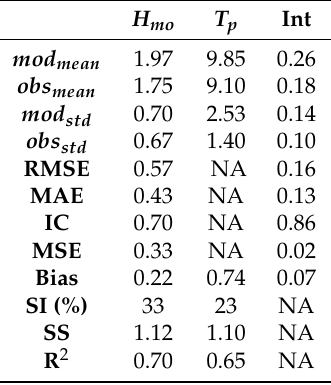
Table 2. Comparison between statistical metrics for wave and current data. Spectral significant wave height ( H mo ), peak period ( T p ) and current intensity (Int) analyzed among the Santa Catarina PNBOIA buoy. RMSE, MAE, Bias, mod mean , obs mean , mod std , obs std are in the same units of the parameters, SI is in percentage. NA = Not Applied. H mo T